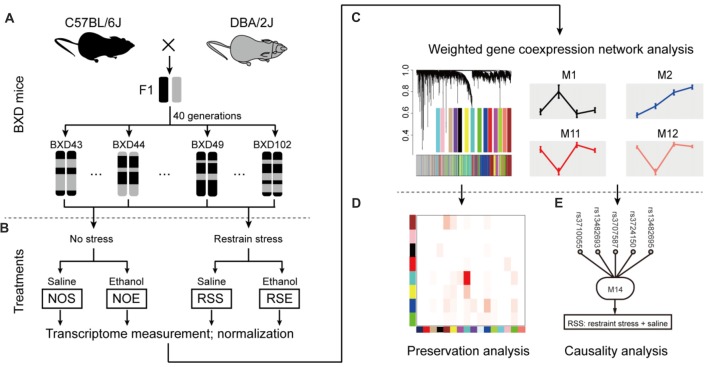
Diagram showing network-based data analysis. (A) The expression data were generated from the BXD recombinant inbred (RI) mice. (B) The transcripts of these four conditions were compared and analyzed. (C) Weighted gene co-expression network analysis by WGCNA. (D) Conservative analysis of gene modules under experimental conditions. (E) Causal analysis.